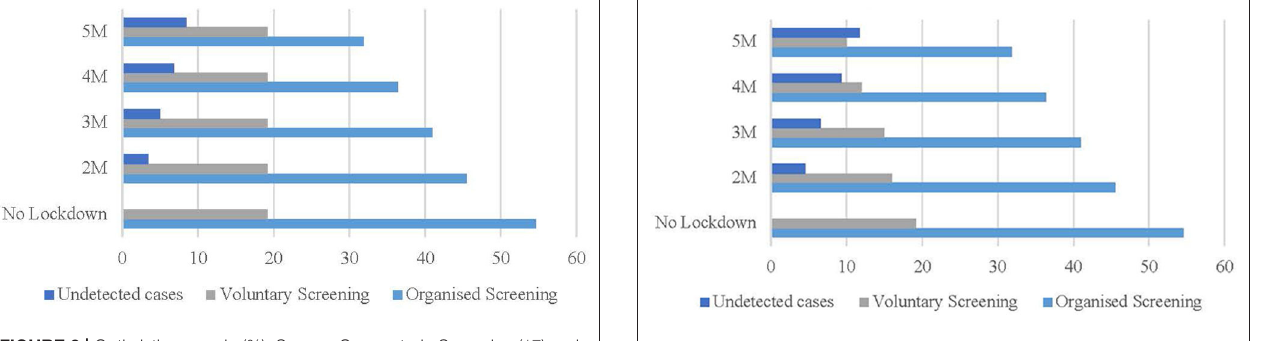
) are that missed has intervened to remove the suspension of all the